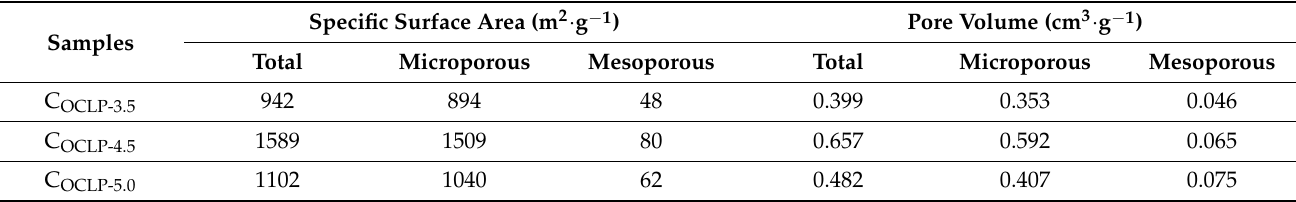
Table 1. Channel structure parameters of the C OCLPs